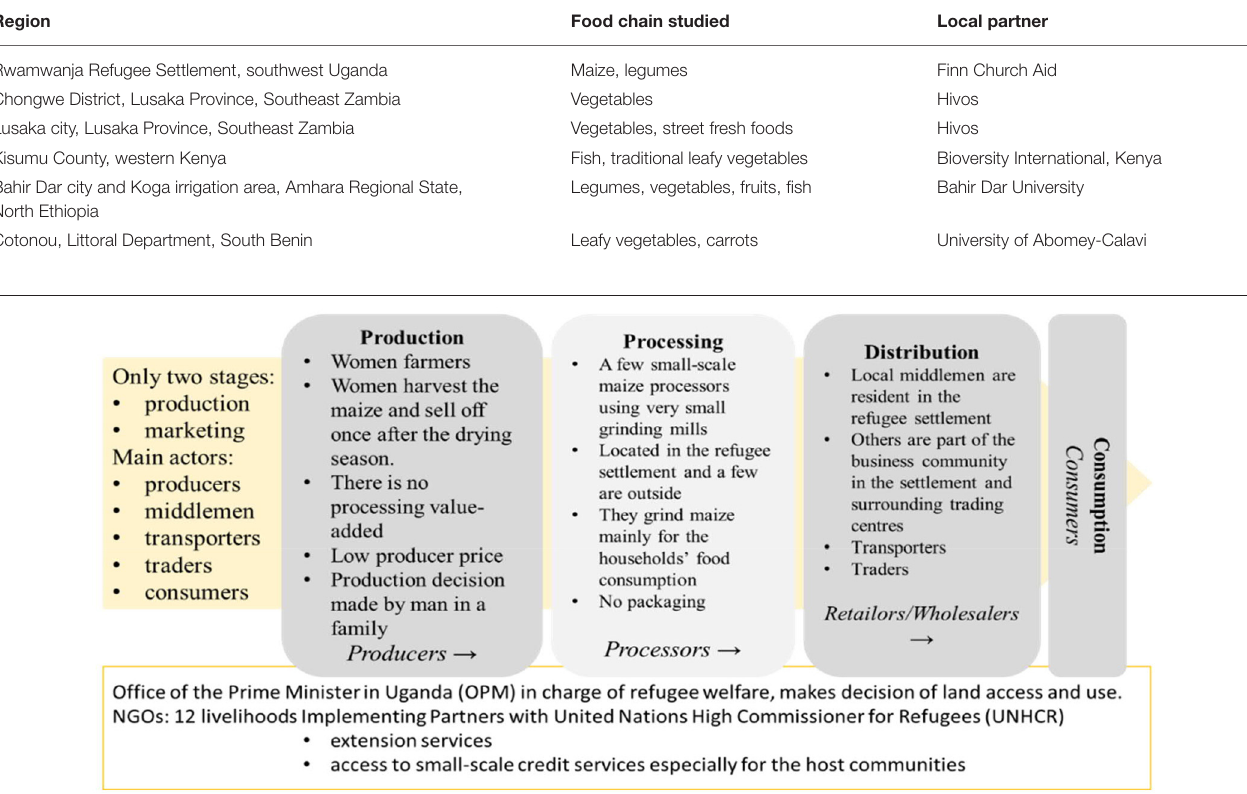
FIGURE 1 | The status quo of maize value chain in Rwamwanja refugee